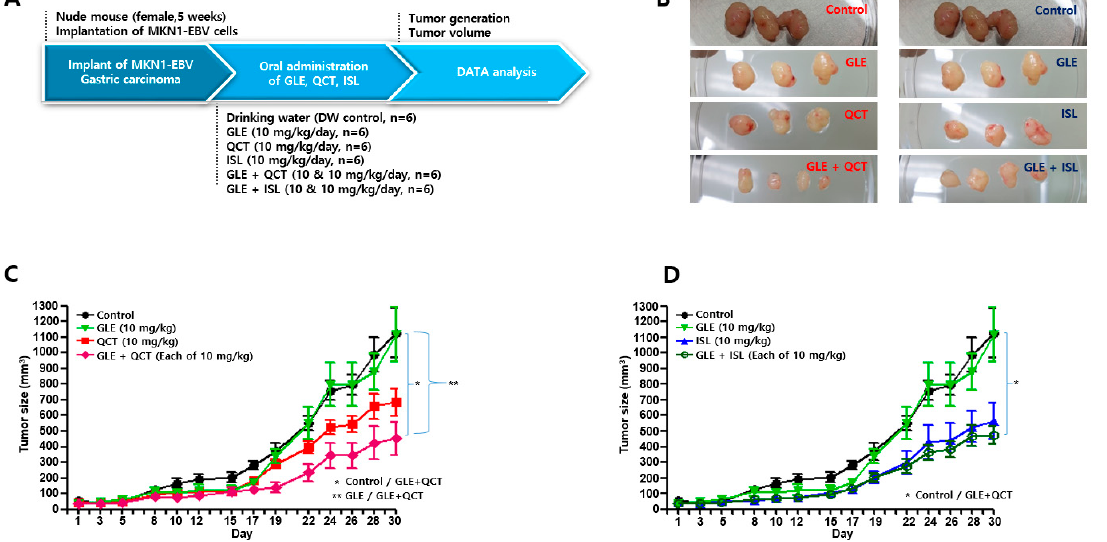
Figure 3. Cotreatment with GLE and QCT at relatively low concentration synergistically suppressed EBVaGC development in xenograft mouse model. ( A ) A schematic diagram of the antitumor assay carried out using a xenograft mouse model. ( B ) A representative image of MKN1-EBV-derived tumors recovered form xenograft nude mice. ( C ) The determination of the antitumor effects of relatively low-concentration GLE (10 mg/kg), QCT (10 mg/kg), and mixture of GLE and QCT (10 + 10 mg/kg) in MKN1-EBV-derived tumors in nude mice. ( D ) The determination of the antitumor effects of low-concentration GLE (10 mg/kg), ISL (10 mg/kg) and a mixture of GLE and ISL (10 + 10 mg/kg) in MKN1-EBV-derived tumors in nude mice. Control versus GLE + QCT, GLE versus GEL + QCT and control versus GLE + ISL were statistically different in tumor sizes. GLE, QCT, and ISL: Ganoderma lucidum extracts, quercetin, and isoliquiritigenin, respectively.